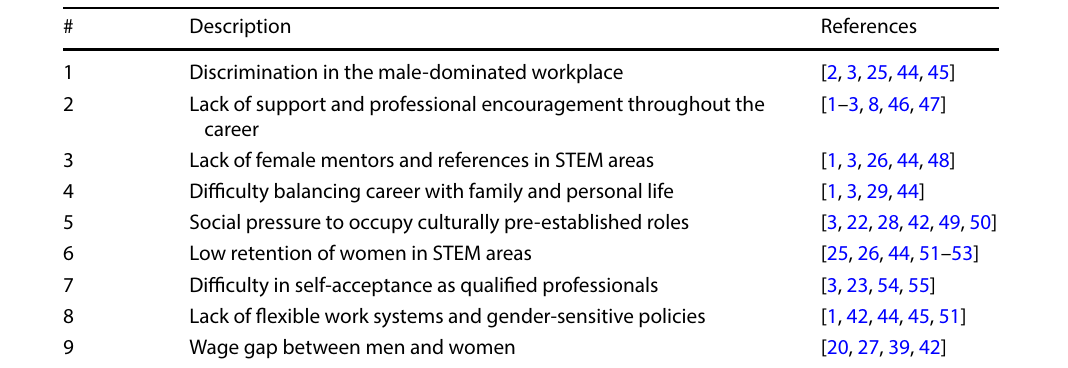
Table 2 Questionnaire used in the interviews with women working in STEM fields